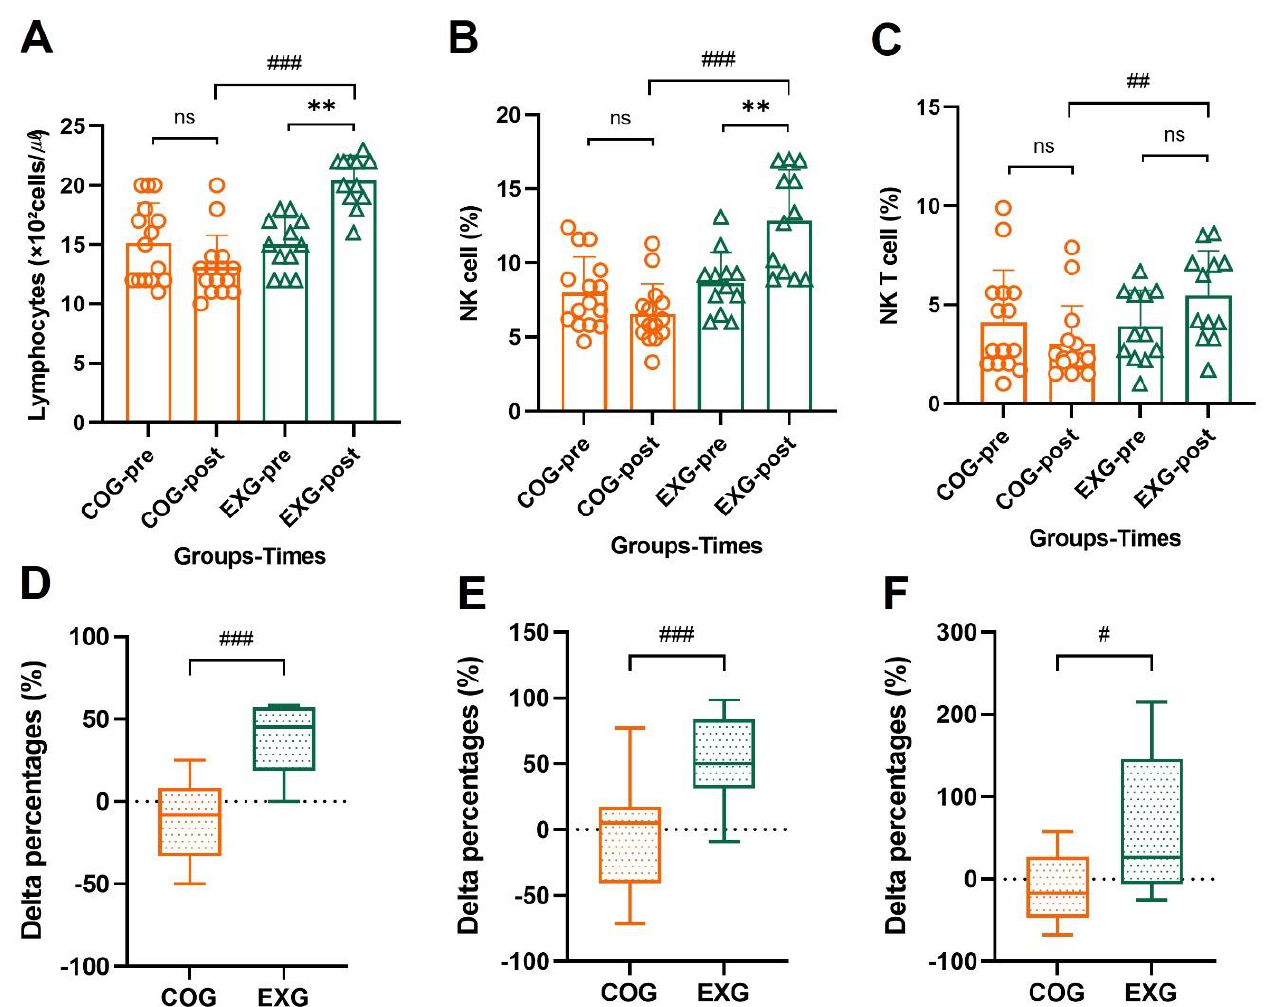
Figure 6. NK and NKT cells of lymphocytes are improved in the ovarian cancer survivors after 12 weeks of aerobic and resistance exercise. ( A ) Lymphocyte’s absolute values in the control group (COG) and in the exercise group (EXG). ( B ) NK cell percentages of lymphocyte’s absolute values in the COG and EXG. ( C ) NKT cell percentages of lymphocyte’s absolute values in the COG and EXG. ( D ) Percentages of lymphocyte analyzed as ∆ % in both groups. ( E ) Percentages of NK cells analyzed as ∆ % in both groups. ( F ) Percentages of NKT cells analyzed as ∆ % in both groups. All data are represented as means ± SD. p -values were calculated by Student’s t test or Mann–Whitney U test. For ( A ) to ( F ), these tests were performed independently at each time point; # p < 0.05, ## p < 0.01, and ### p < 0.001. p -values were calculated by Student’s t test or Wilcoxon signed rank test. For ( A ) to ( C ), these tests were performed dependently at each time point; ns: p > 0.05 and ** p <